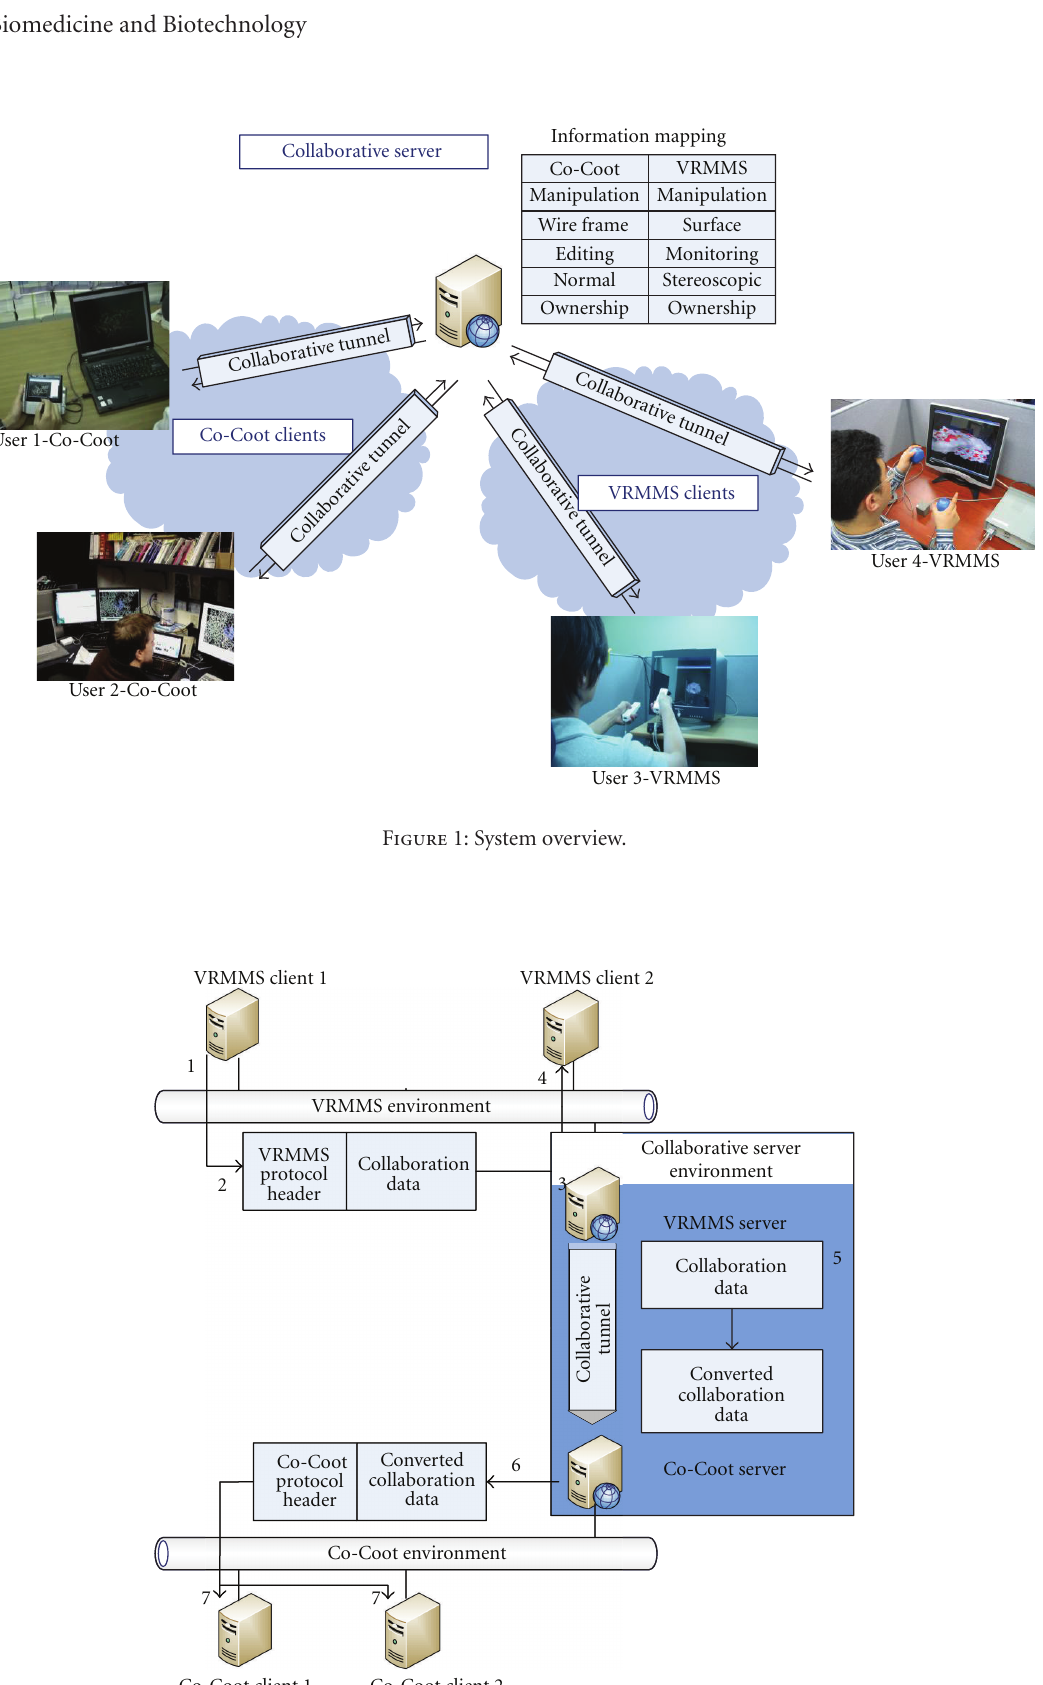
Figure 2: Collaborative tunneling